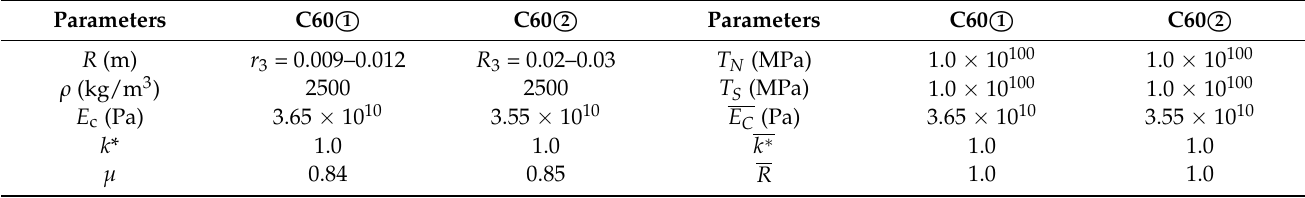
Table 3. Micro-parameters of C60 in the DEM